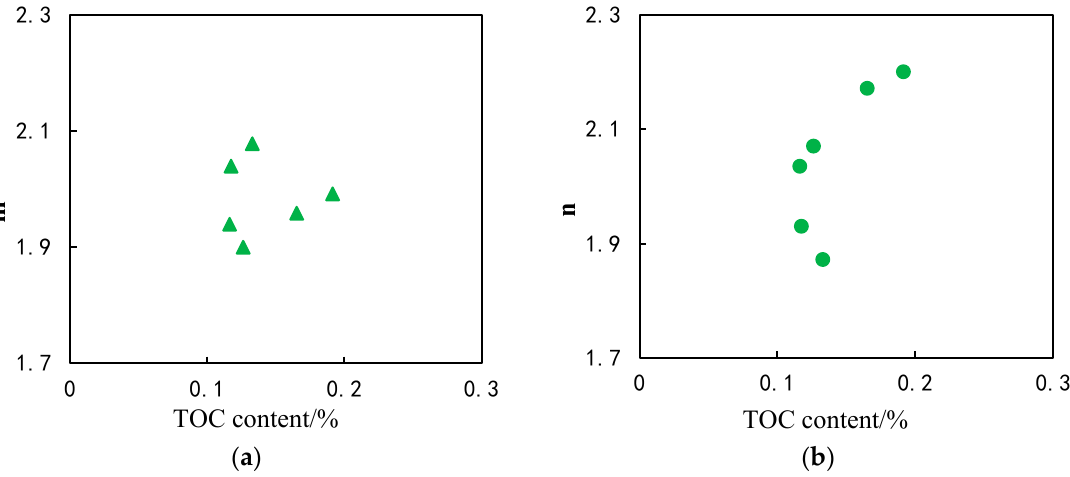
Figure 7. Relationship between TOC content and rock electrical parameters of core samples of the Quaternary mudstone biogas reservoir. ( a ) Relationship between m and TOC content. ( b ) Relationship between n and TOC content.